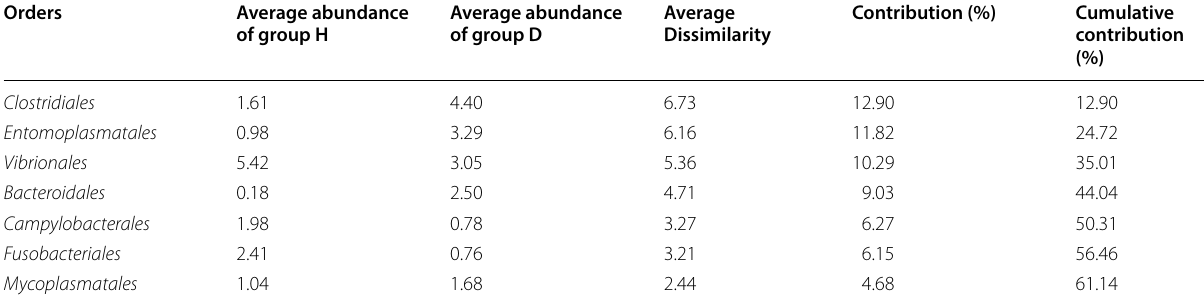
Group H is the healthy crab group, and group D is the Baimang diseased crab group